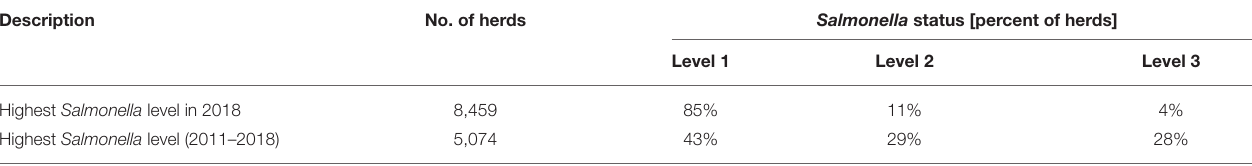
TABLE 1 | Distribution of Danish pig herds according to their Salmonella levels based on highest level during a year. Description